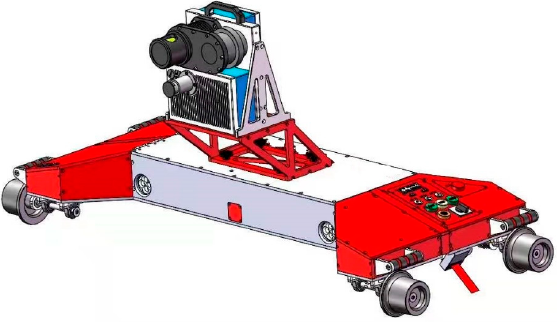
Figure 1. Data acquisition hardware system diagram. Table 1. Technical specifications of the Z + F PROFILER ® 9012M.